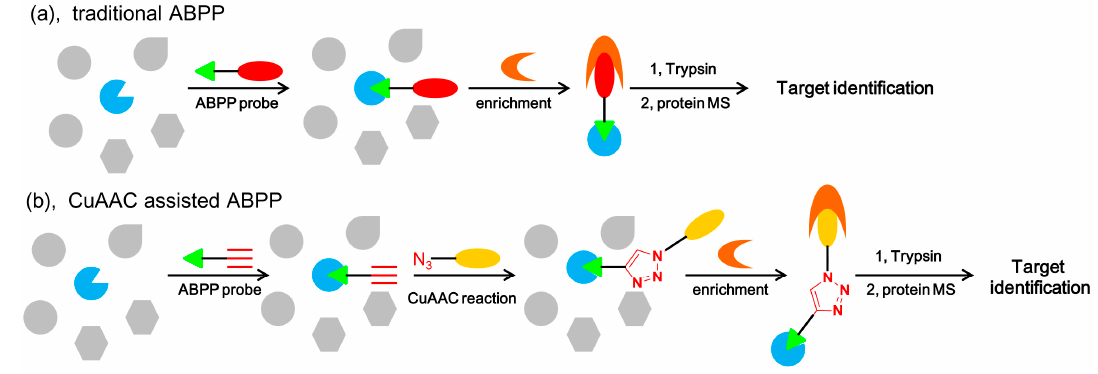
Figure 3. Traditional ABPP ( a ) vs. CuAAC-assisted ABPP ( b ).